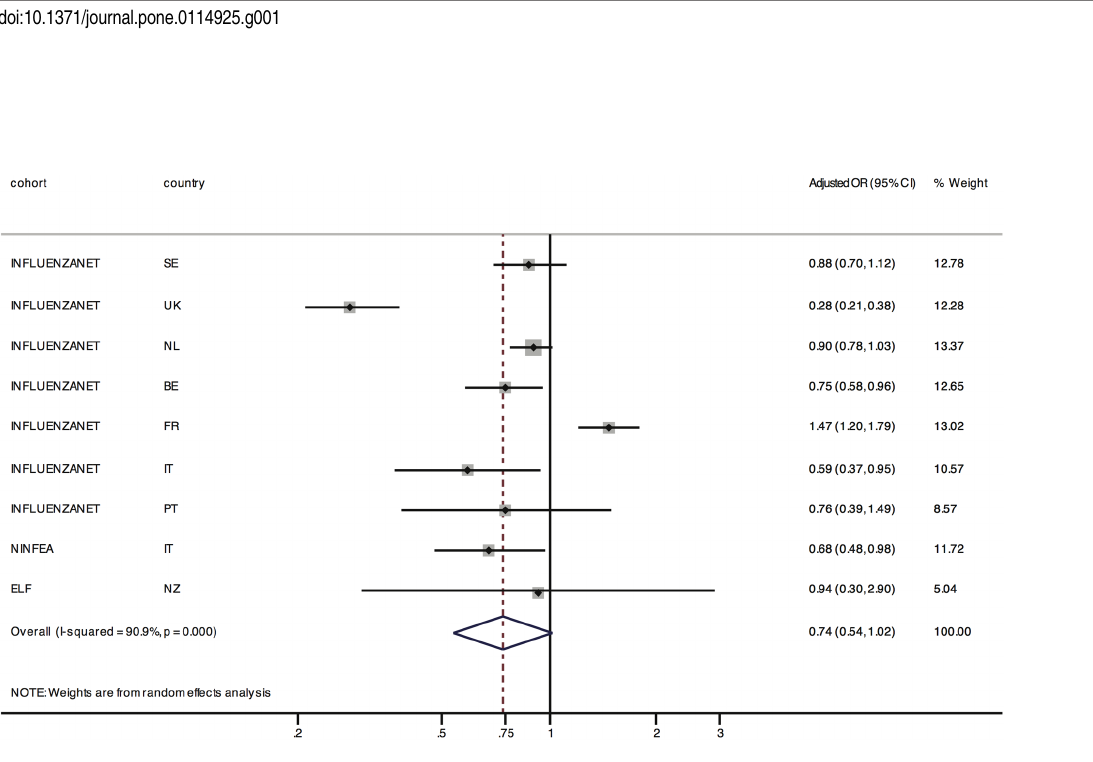
Fig. 1. Summary of the results reported in Table 2. The effect of face-to-face recruitment on follow-up participation compared to offline recruitment is shown. Given that the studies are highly heterogeneous by design and target different populations, the pooled estimate should be considered as an average of the study-specific effects rather than as a causal estimate.